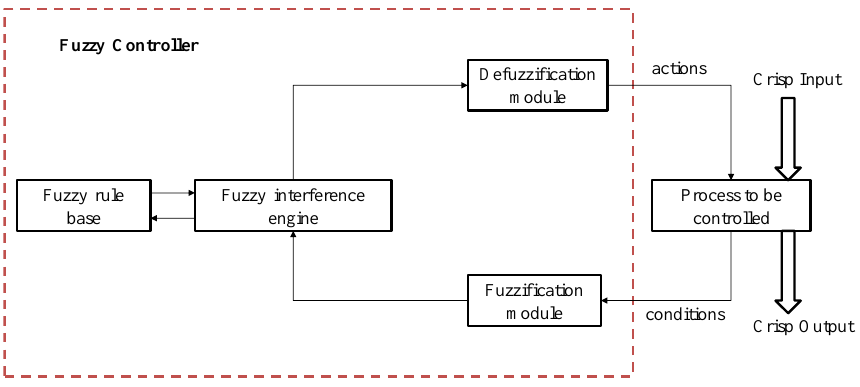
Figure 3. Structure of the fuzzy logic controller.